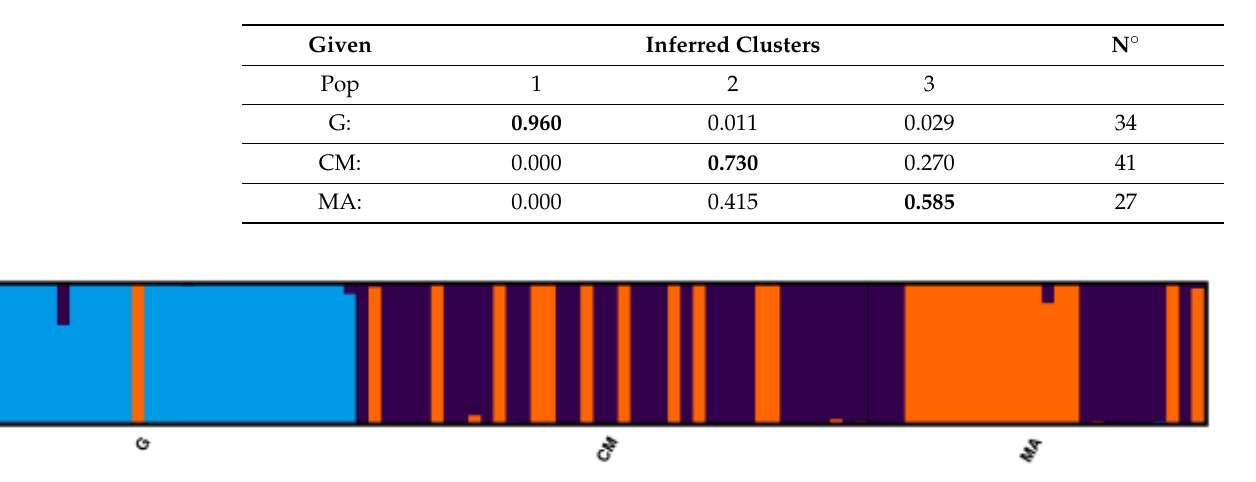
Figure 3. Genetic structure of the studied chestnut trees as inferred by Bayesian clustering of SSR genotypes at K = 3. Each vertical bar represents a single tree and the proportion of membership to a genetic pool is indicated by the different colours.